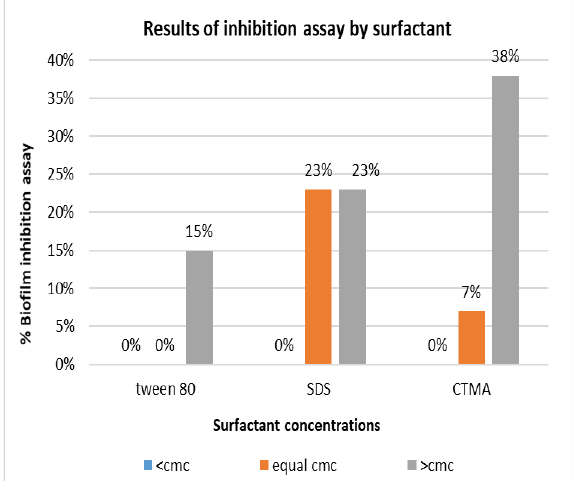
Lane M is a DNA marker (50-1500bp). Lanes 1-13 are positive for CsgA gene. Figure 3. Percent of inhibition of biofilm formation by the 13 E. coli isolates by using different concentrations of the surfactants